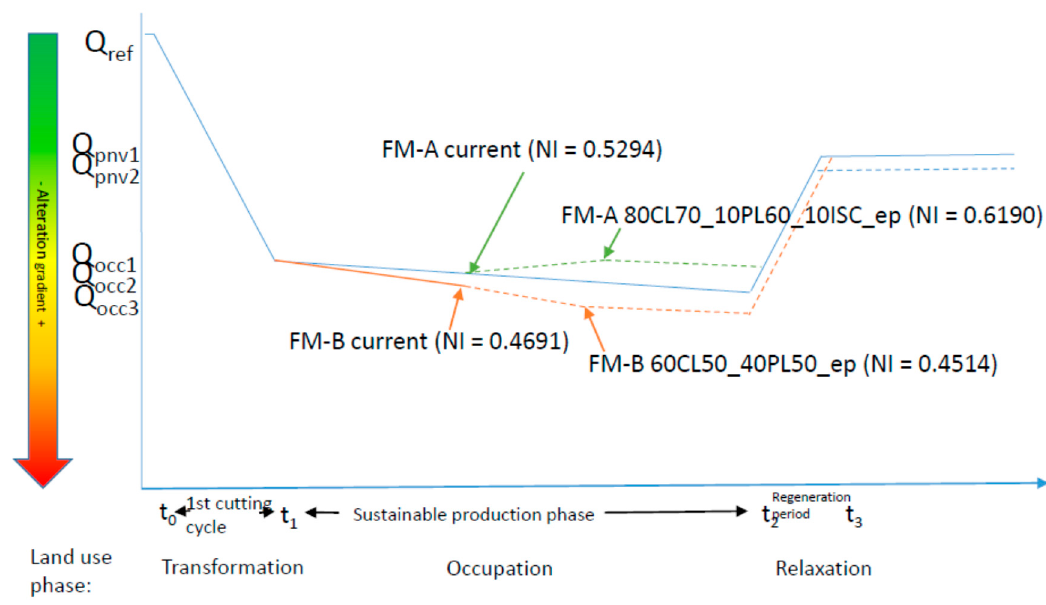
Figure 5. Ecosystem quality evolution thru time. Q ref : Quality at the reference state (natural); Q PNV : Quality of the Potential Natural Vegetation that have been regenerated after land use; Q PNV1 : with low permanent impacts; Q PNV2 : with higher permanent impact; Q occ : Quality during occupation phase; Q occ1 : for the scenario with the lower impact; Q occ2 : for the mid-impact scenario; Q occ3 : for the lower impact scenario; FM-A 80CL70_10PL60_10ISC_ep: scenario for FM-A figuring 80% of the productive area in clearcut careful logging on a rotation of 70 years, plus 10% in plantation on a 60 years rotation and 10% subject to irregular shelterwood cutting, with the enhanced level of protection; FM-B 60CL50_40PL50_ep: scenario for FM-B figuring 60% of the productive area in clearcut careful logging on a rotation of 50 years, and 40% in plantation on a 50 years rotation, with the enhanced level of protection; NI : Naturalness index.